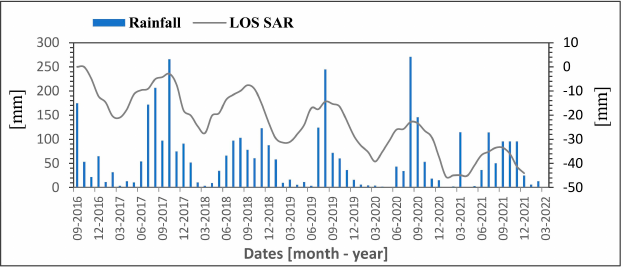
Figure 10. Comparison plots of the InSAR time series and monthly rainfall between September